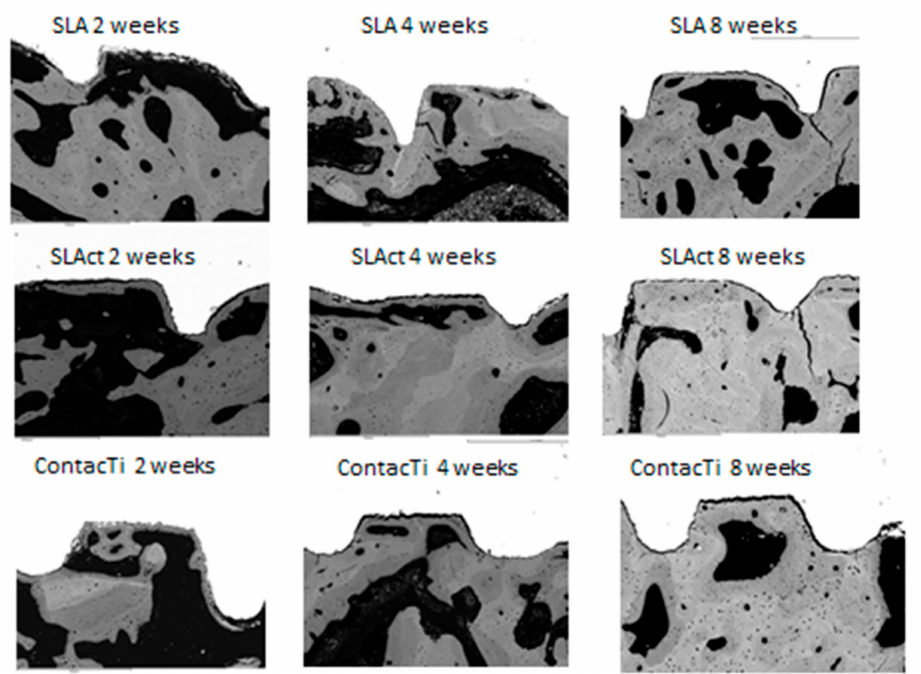
Figure 1. Representative histological images of the three surfaces (ContacTi ® , SLA = SLA ® , SLAct = SLActive ® ) in the jaw at the di ff erent time points of the study (2, 4, and 8 weeks). Magnification 75 × . Both surfaces underwent a similar evolution at 8 weeks, showing a large amount of lamellar tissue as well as strong osteoconductivity. There was a significant amount of mature lamellar tissue and minimal vascular space; thus, there was a high level of maturity and bone quality, indicating an ® advanced state of bone remodelling. The SLA surface showed a slower rate of maturation (Figures 1 and